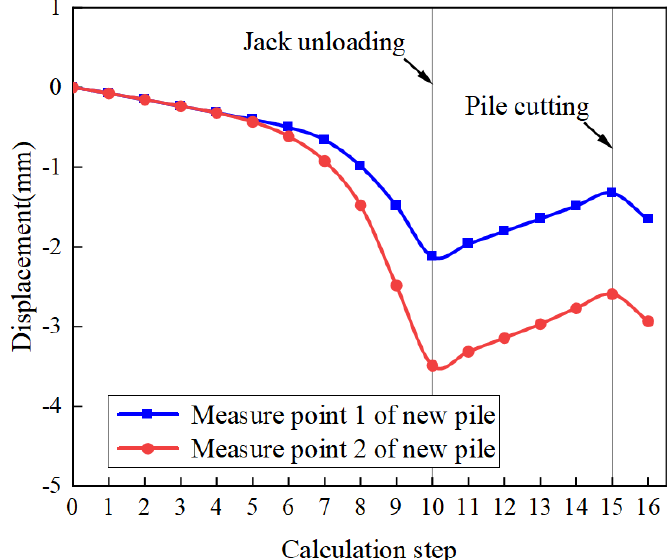
Figure 7. Displacement of the new piles calculated by numerical modelling.